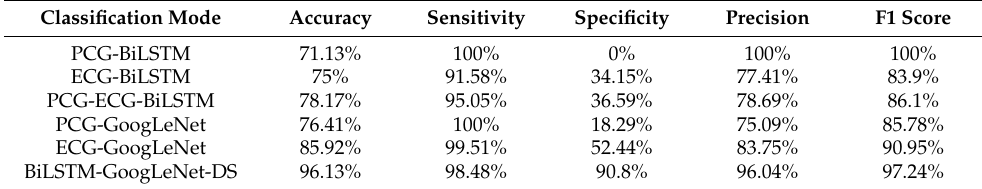
Table 3. Comparison of several algorithm models.